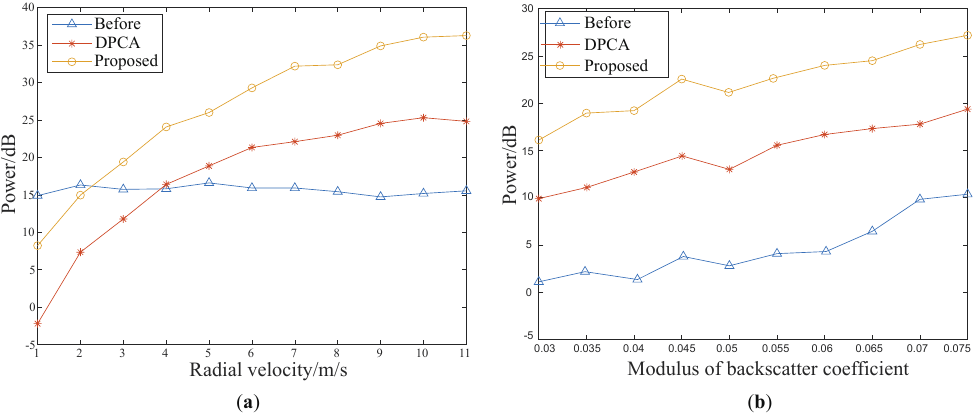
Figure 12. Experimental results and comparisons, ( a ) Comparisons of the power variation of a moving target versus radial velocity before and after clutter suppression by the DPCA and the proposed multilayer channel-cancellation, ( b ) Comparisons of power variation of a moving target (8 m/s) versus input SCR before and after clutter suppression by the DPCA and the multilayer